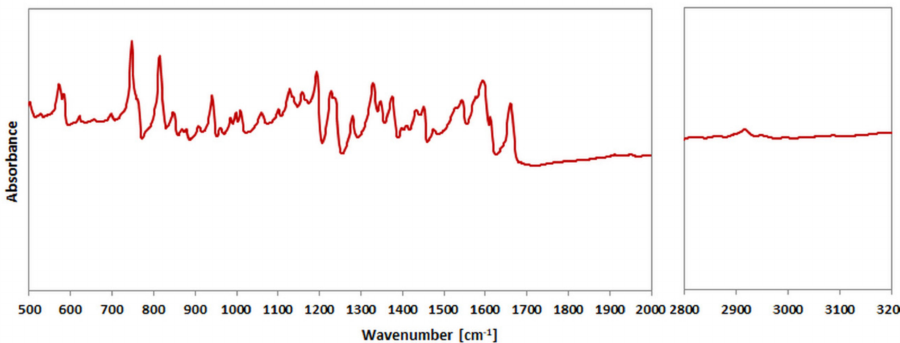
Figure 7. The observed IR absorption spectra of 2-(4-dimethylamino)benzoylbenzoxazole ( 1b ) in the region 500–2000 cm − 1 and 2800–3200 cm − 1 .